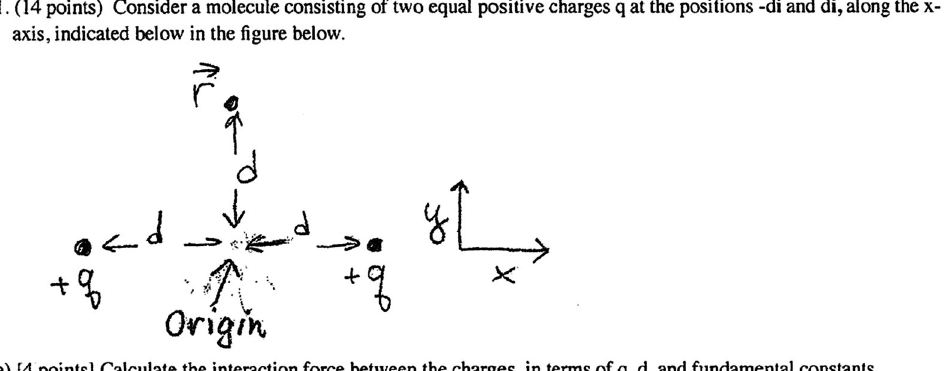
FIG. 4. A sample exam problem from TP